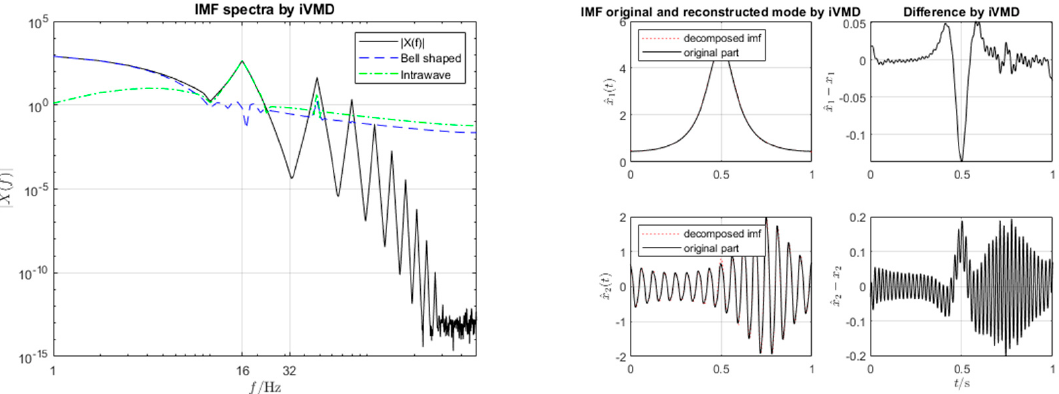
Figure 6. iVMD decomposition of x Sig3 ( t ) run via iVMD. The left shows the IMF’s spectra, and the right shows the reconstructed modes. In the reconstructed modes, we show four figures. The left two are the IMFs, and the right two show the differences between the estimated IMF and the original.